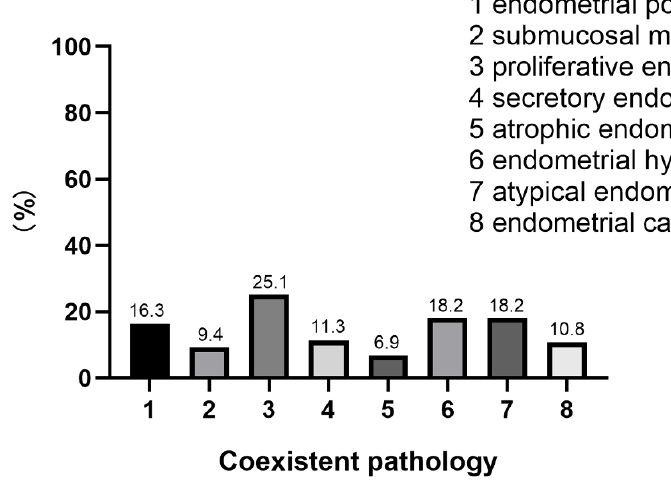
Figure 1. The coexistent pathologies associated with APA.